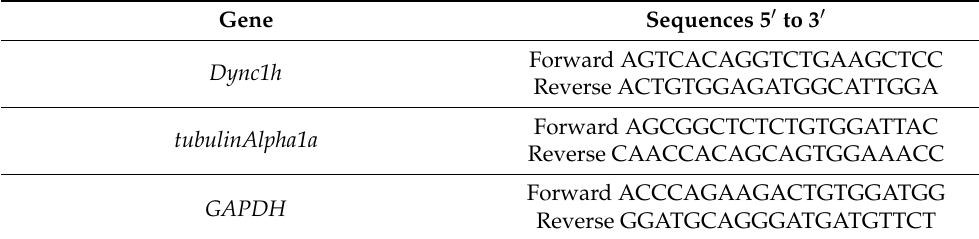
Table 1. Primers for real-time